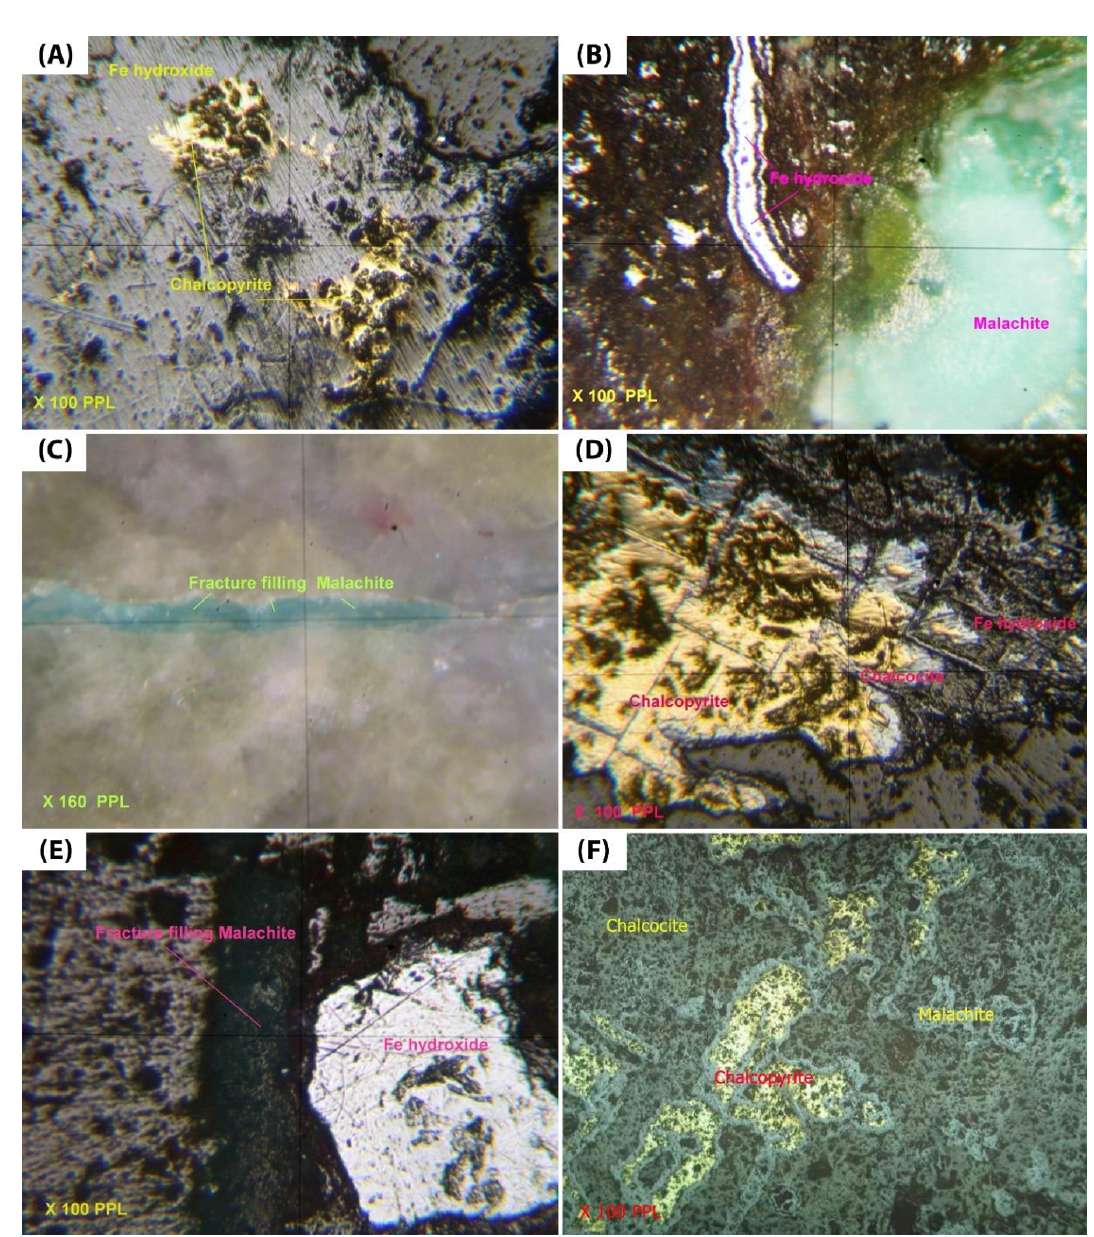
Figure 2. Selected polished sections prepared from collected samples of copper mineralizations in the Sahlabad area. ( A ) Mesgaran Deposit: Chalcopyrite and Fe-hydroxide; ( B ) Mesgaran Deposit: Malachite and Fe-hydroxide; ( C ) Chah-Rasteh Deposit: Fracture Filling Malachite; ( D ) Chah-Rasteh